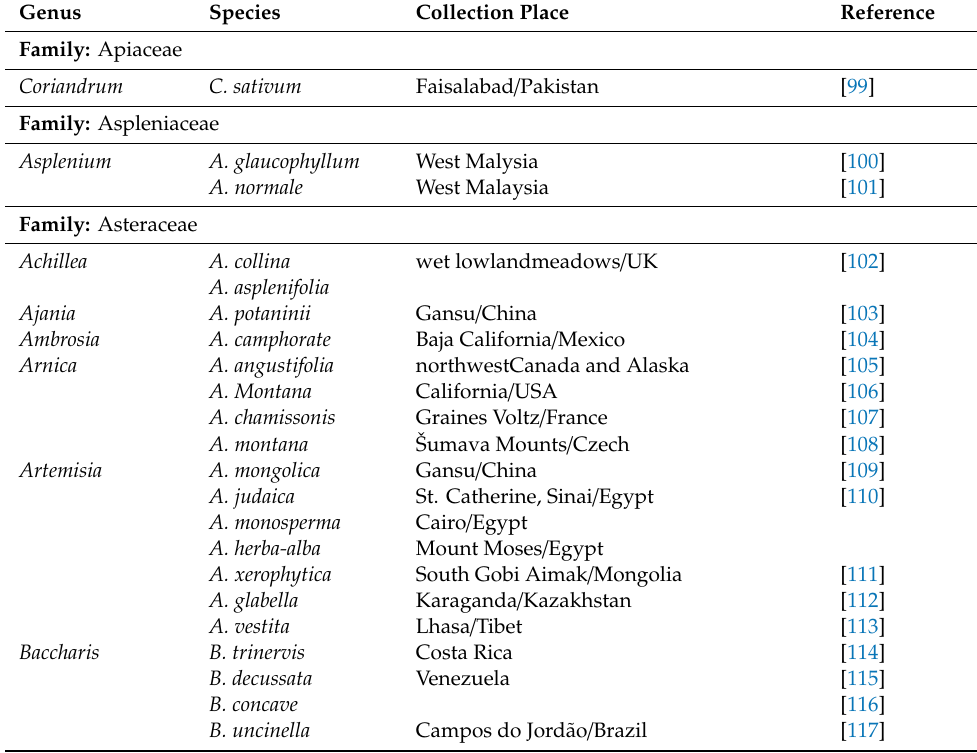
Table 2. Isolation of pectolinarigenin from the indicated plants, classified according to family, genus and species, and place of